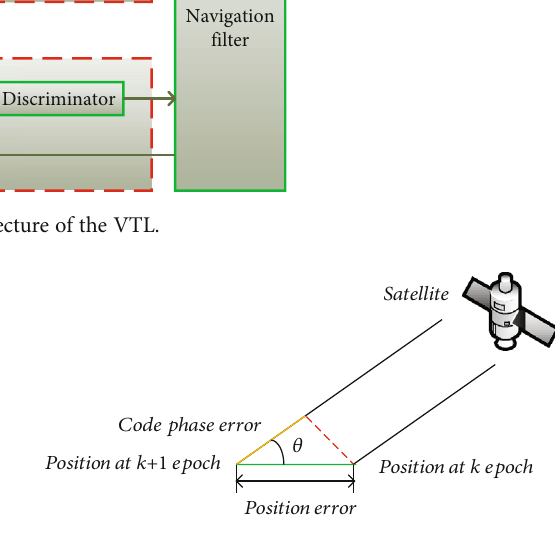
Figure 4: Relationship between the code phase and the position